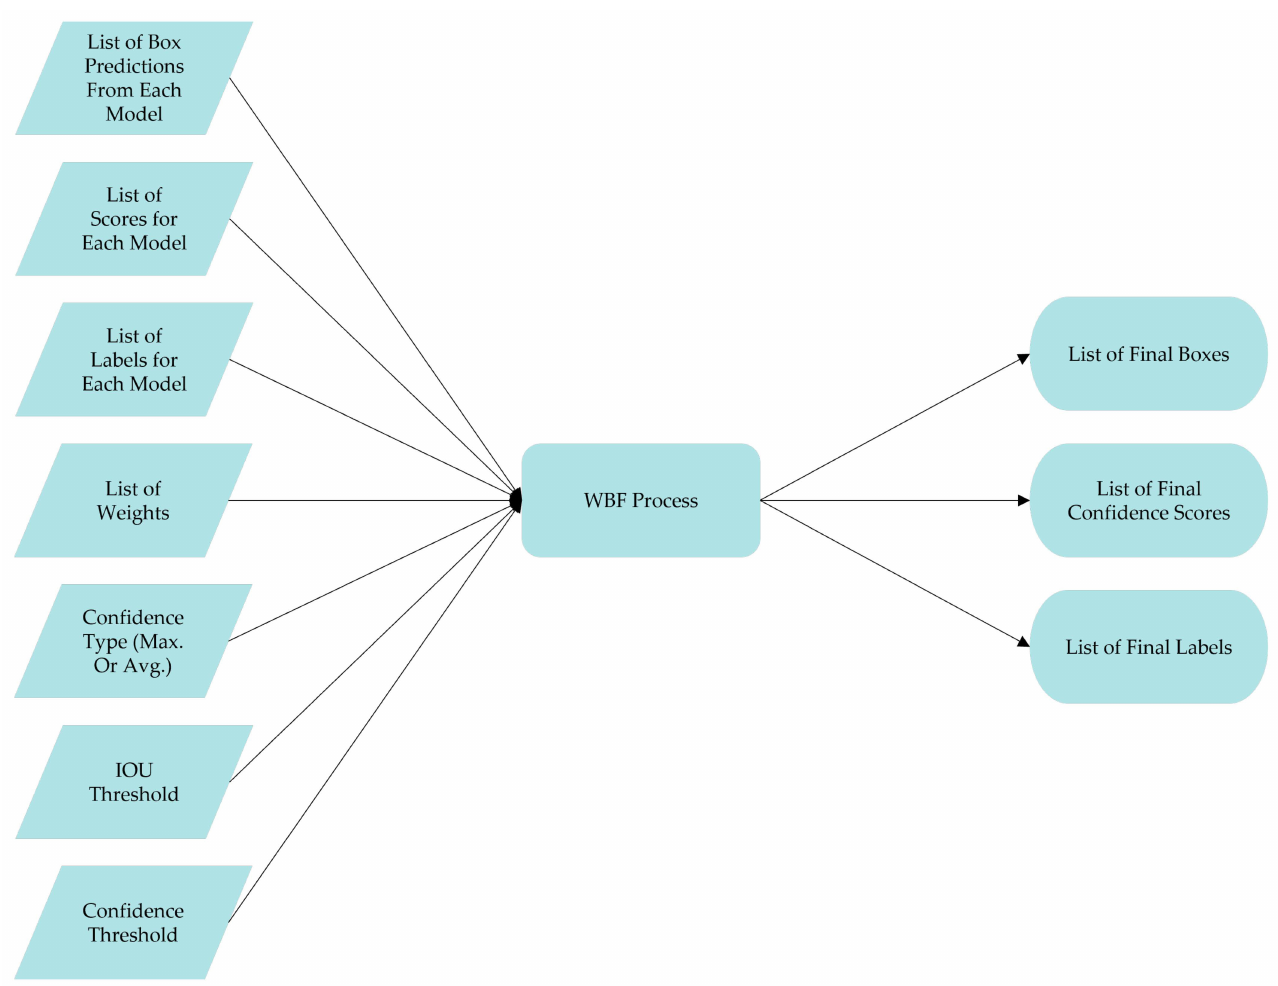
Figure 6. Weight boxes fusion ensemble.